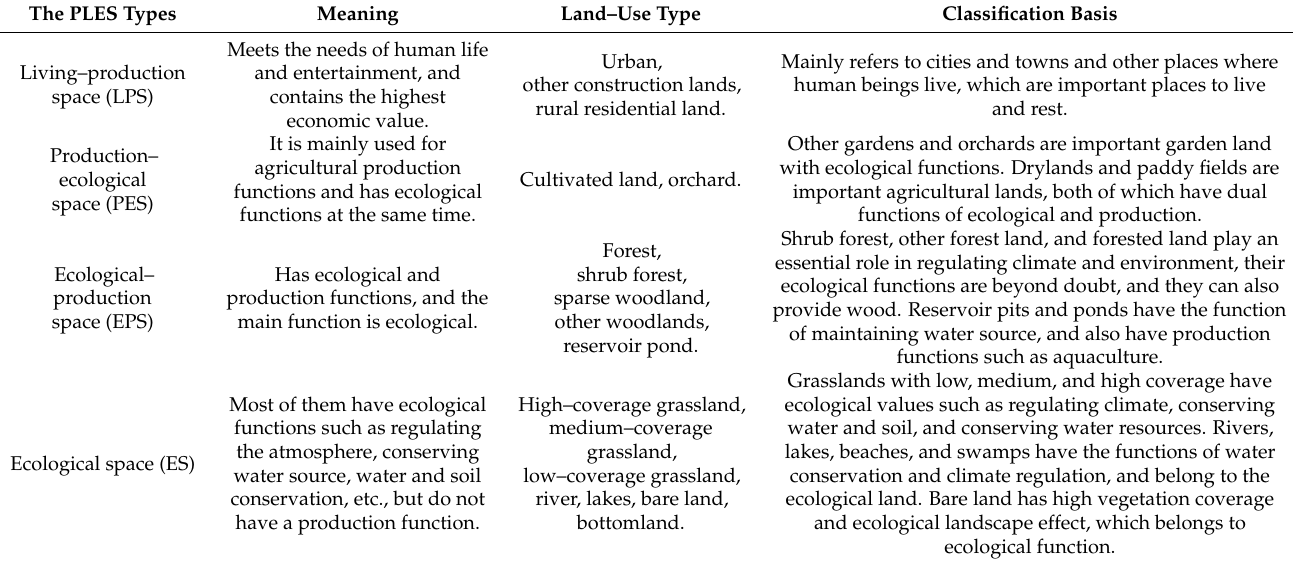
Table 1. The PLES classification